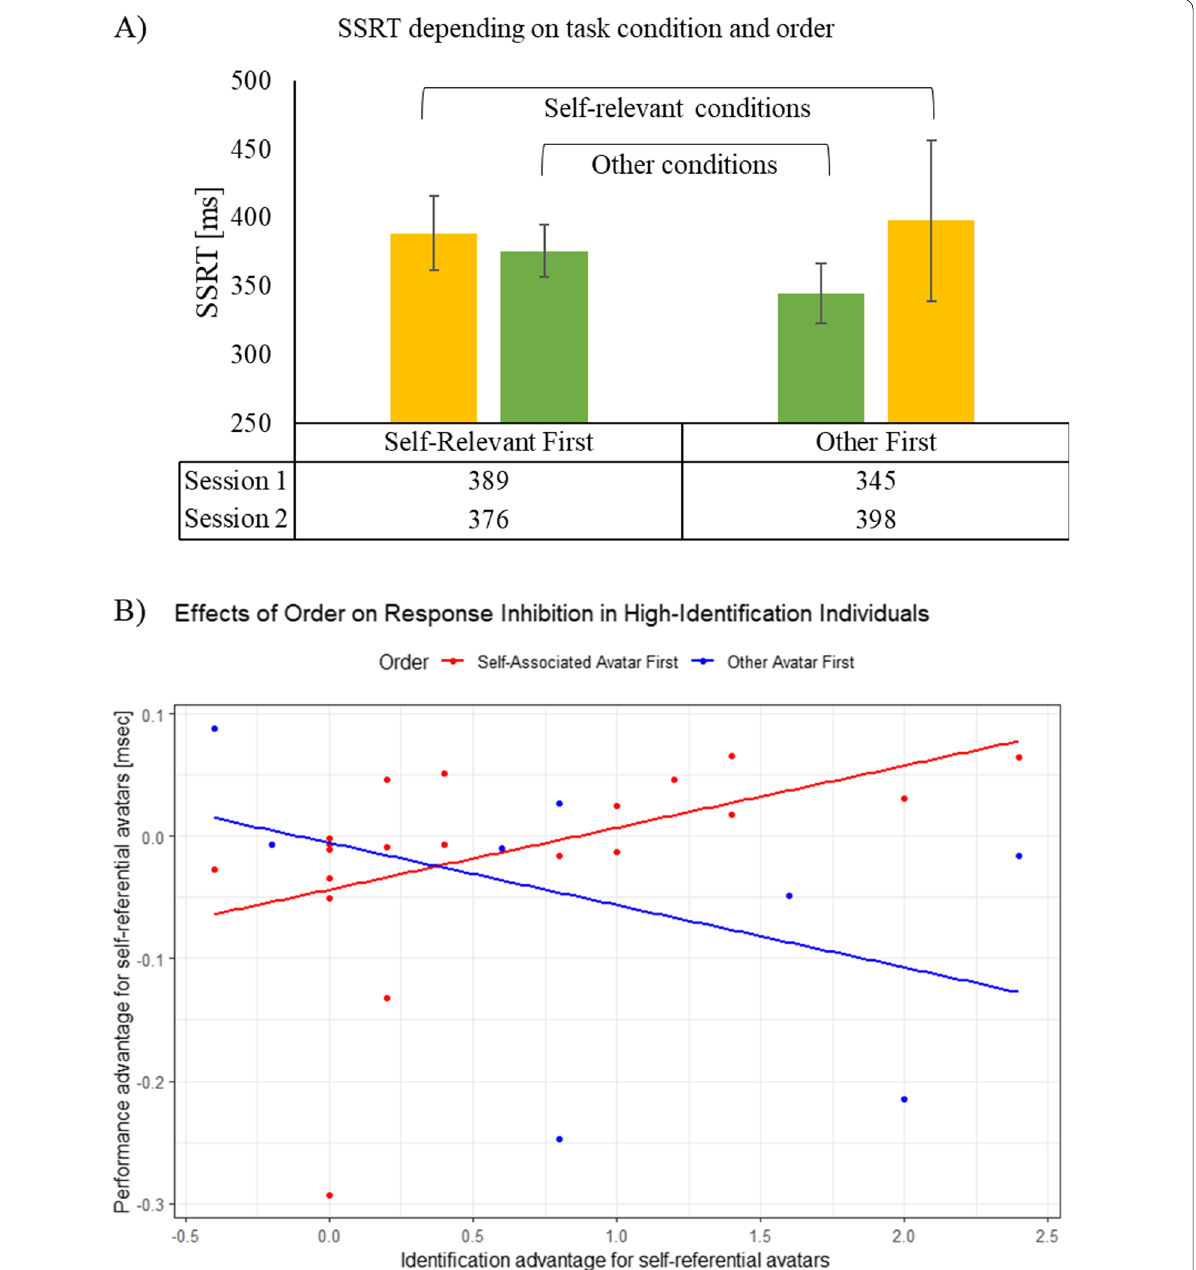
Fig. 8 Only participants that identified with the self-relevant avatar (i.e., for whom the manipulation was successful) were considered for this analysis. Note that in the stop-signal paradigm, a lower SSRT indicates a better performance. A lower SSRT means that the estimated inhibition process is faster. A Descriptive statistics for both conditions depending on the task order in which they were completed. If participants played the self-relevant condition first, their SSRT (i.e., the response inhibition speed) improved from session 1–2; vice versa for the other order condition. Error bars depict the standard error of the mean. B Increased identification through similarity with the avatar is predictive of a performance change; as measured by the difference in SSRT between the two conditions. Self-reference was induced by the SPE, as opposed to customization as in Experiment 1. The higher identification with the self-relevant avatar, when it was used first, leads to a larger difference between the task conditions, which correspond to session 1 and 2. This performance difference is predicted by the strength of the identification with the